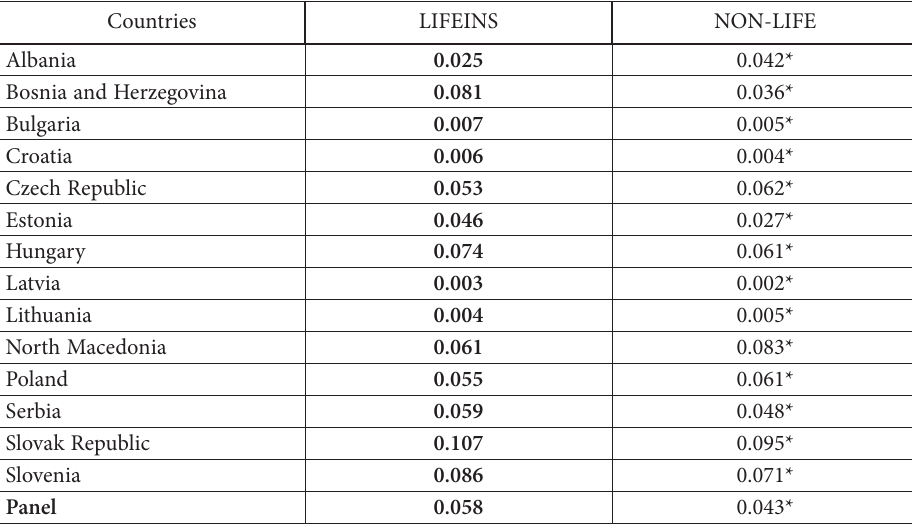
Table 7. FMOLS cointegration coefficient